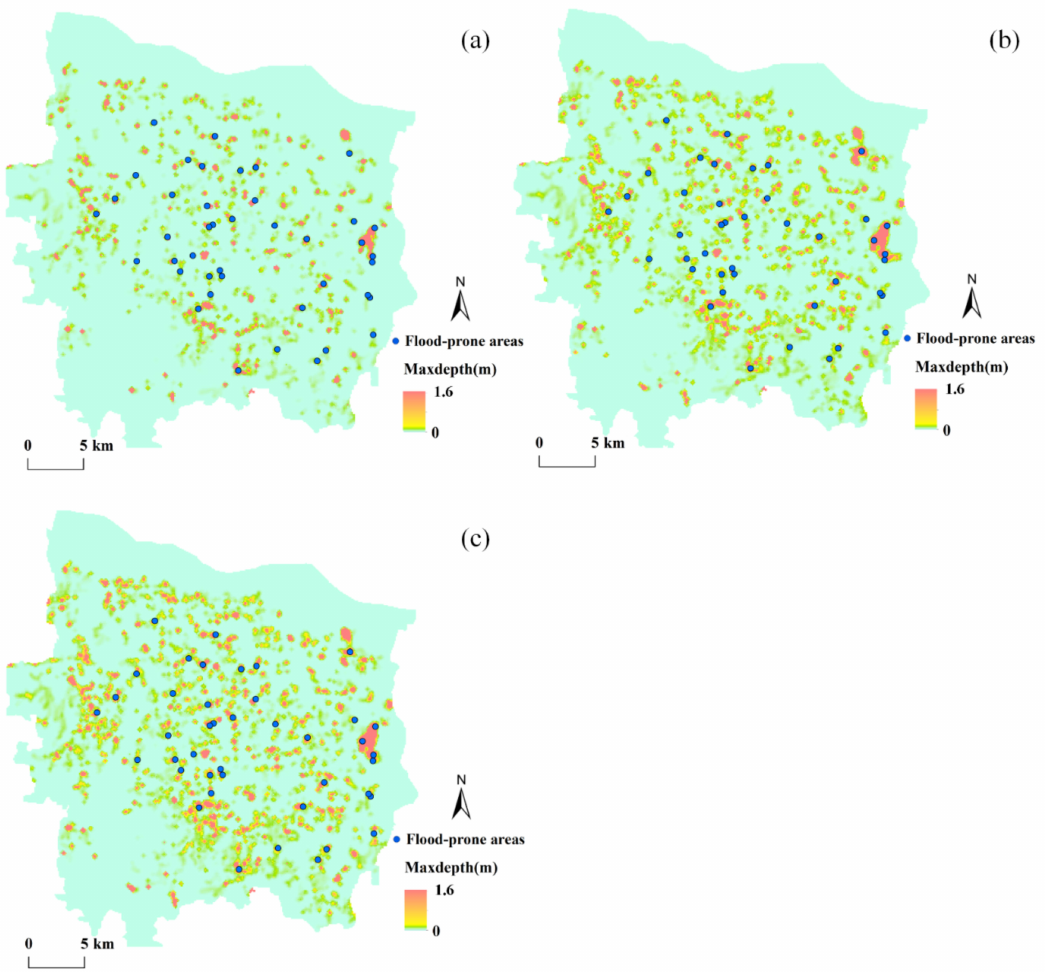
Figure 5. ( a ) Simulation results of rainfall during 10 year return period, ( b ) 50 year return period, and ( c ) 100 year return